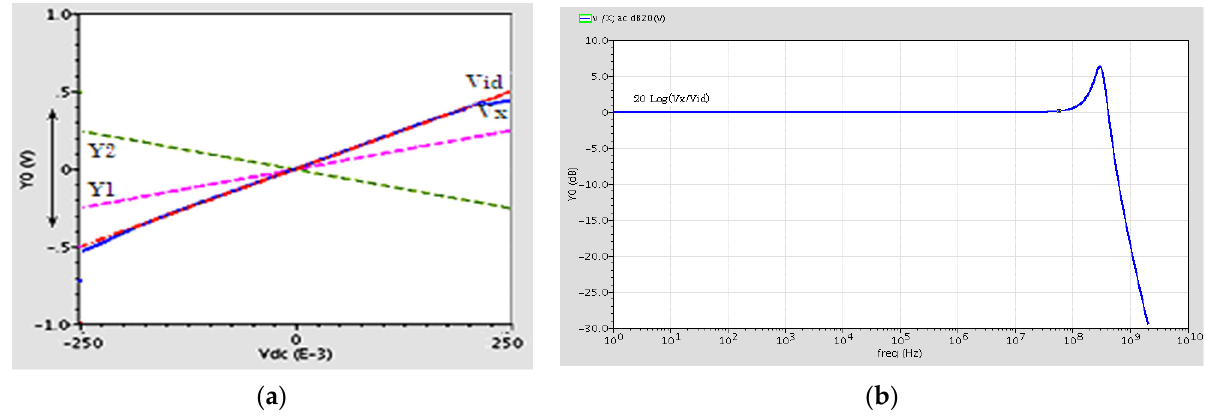
Figure 3. ( a ) The X terminal output voltage versus changes of V id . ( b ) Frequency response of the DVCC.